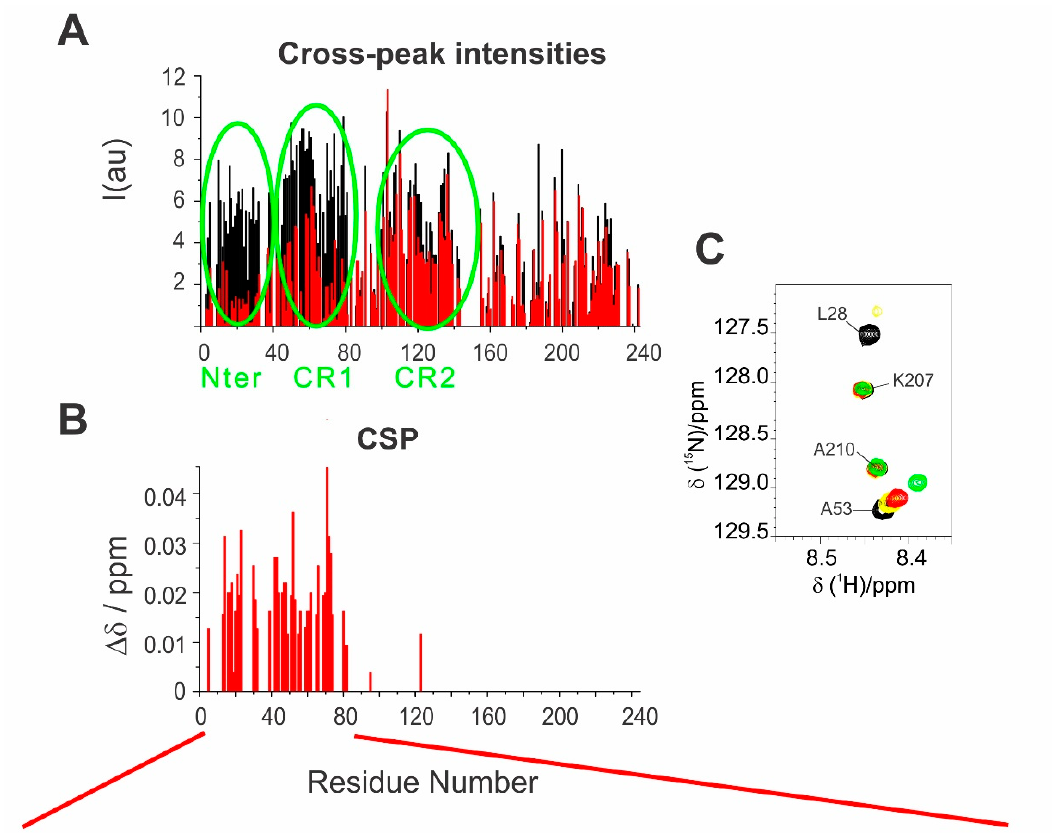
Figure 4. ( A ) Comparison of the cross-peak intensities in 1 H- 15 N BEST-TROSY experiments for E1A12S in the isolated form (black) and E1A12S:CBP-ID4 1:1 complex (red); ( B ) mapping the chemical shift perturbations of E1A12S signals in the E1A12S:CBP-ID4 1:1 complex using the Garrett equation; ( C ) comparison of a selected region of 1 H- 15 N BEST-TROSY spectrum of E1A12S (black), E1A12S:CBP-ID4 1:0.5 (yellow), E1A12S:CBP-ID4 1:1 (red), and E1A12S:CBP-ID4 1:2 molar ratio (green) with signals assignment.